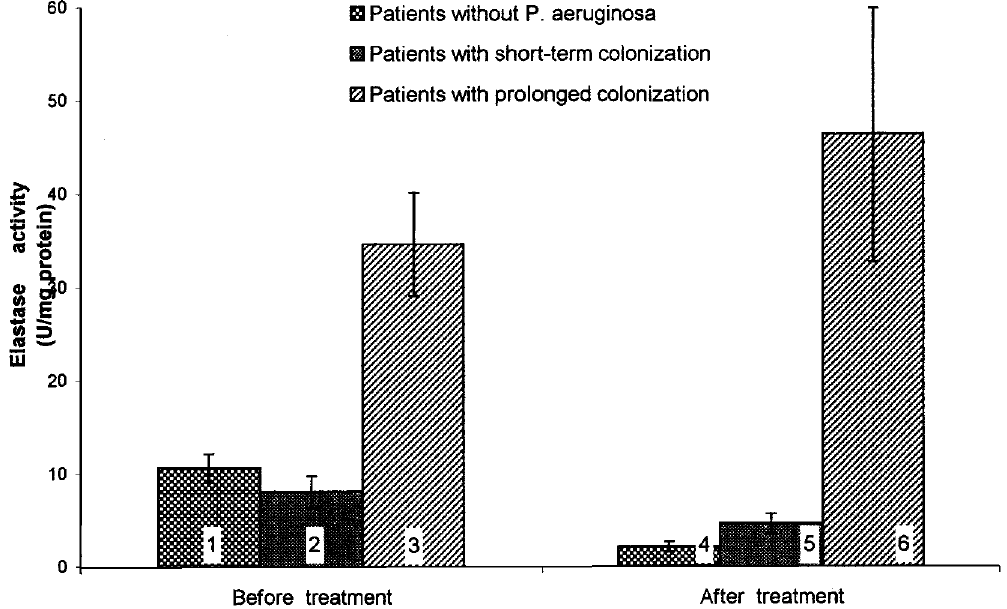
FIG. 1. Neutrophil elastase activity in the lung of CF patients before and after antibiotic treatment., Sputum samples from CF patients with different P. aeruginosa status were assessed for protease presence as described in Materials and Methods. Results are given as units of elastase activity per mg protein and expressed as mean ± SEM. A two sample Student’s t -test was used to compare the means of elastase activity in separate patient groups before and after antibiotic treatment ( p 1,4 <0.03; p 2,5 <0.02). Differences in elastase activity levels between patient groups were analyzed using paired, two-tailed Student’s t -test ( p 1,3 <0.003; p 4,6